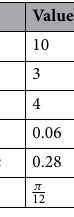
Table 1. The values of parameters utilized for